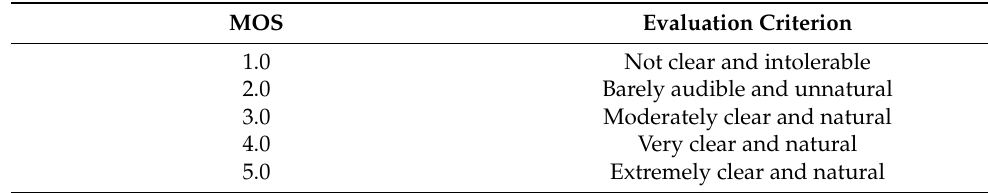
Table 1. MOS scoring